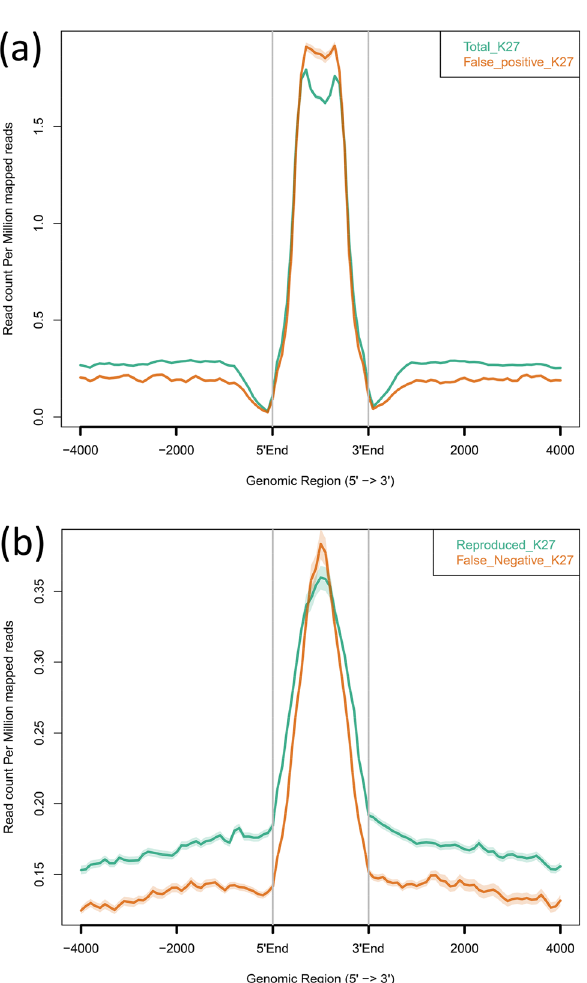
Figure 7. The evaluation of false positive and negative peaks for H3K27me3 in NTU-CAT. ( a ) Average profile plot of the H3K27me3 signals in total NTU-CAT peaks and false positive peaks in the NTU-CAT Rep1 sample shown in Fig. 6a. The figures was generated by ngs.plot 28 . ( b ) Average profile plot of the H3K27me3 signals in reproducible and missing (false negative in NTU-CAT) peaks in ChIP-seq compared with NTU-CAT. The overlapping peaks of H3K27me3_1 and 2 in our previous ChIP-seq report 17 was compared with the NTU-CAT Rep1 sample shown in Fig. 6a. The figure was generated by ngs.plot 28 using the H3K27me3_1